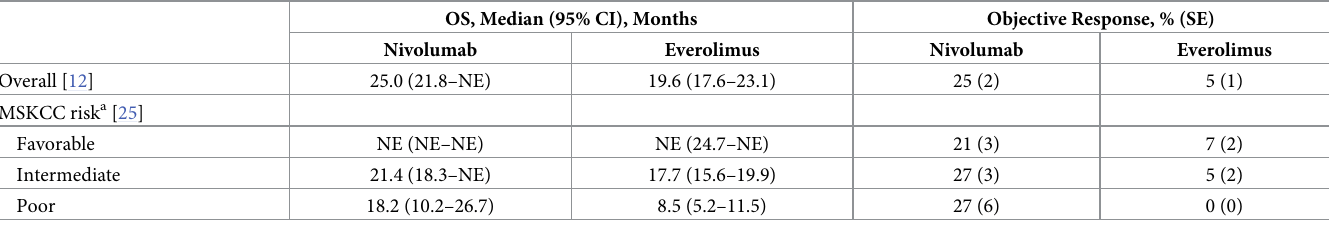
Table 1. CheckMate 025 study results.